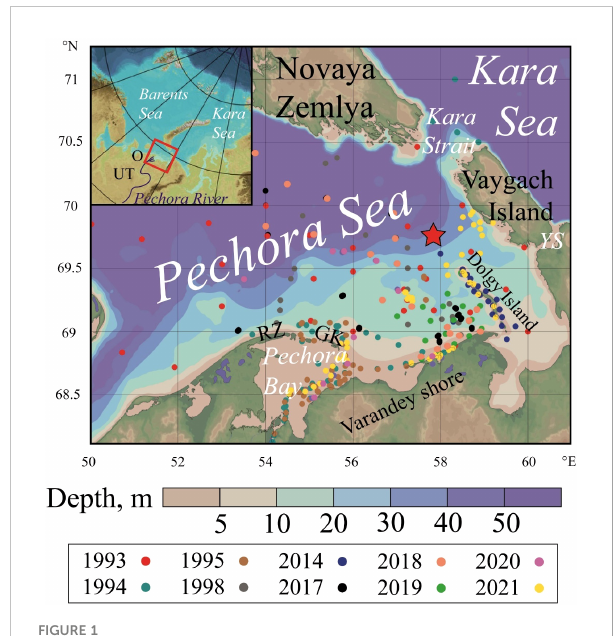
FIGURE 1 Bathymetry of the Pechora Sea, locations of CTD stations (colored circles) and location of the mooring station (red star) analyzed in this study. RZ denotes the Russkiy Zavorot peninsula, GK denotes the Gulyaevskie Koshki archipelago, which bound the Pechora Bay; KS denotes the Kara Strait, YS denotes the Yugorsky Strait, which connect the Pechora and Kara seas. The inset demonstrates location of the Pechora Sea (red rectangle) in the Western Arctic; the Pechora River and the river gauge stations Oksino (O) and Ust- Tsilma (UT) (green squares). The bathymetric data was taken from the International Bathymetric Chart of the Arctic Ocean (IBCAO) (Jakobsson et al.,